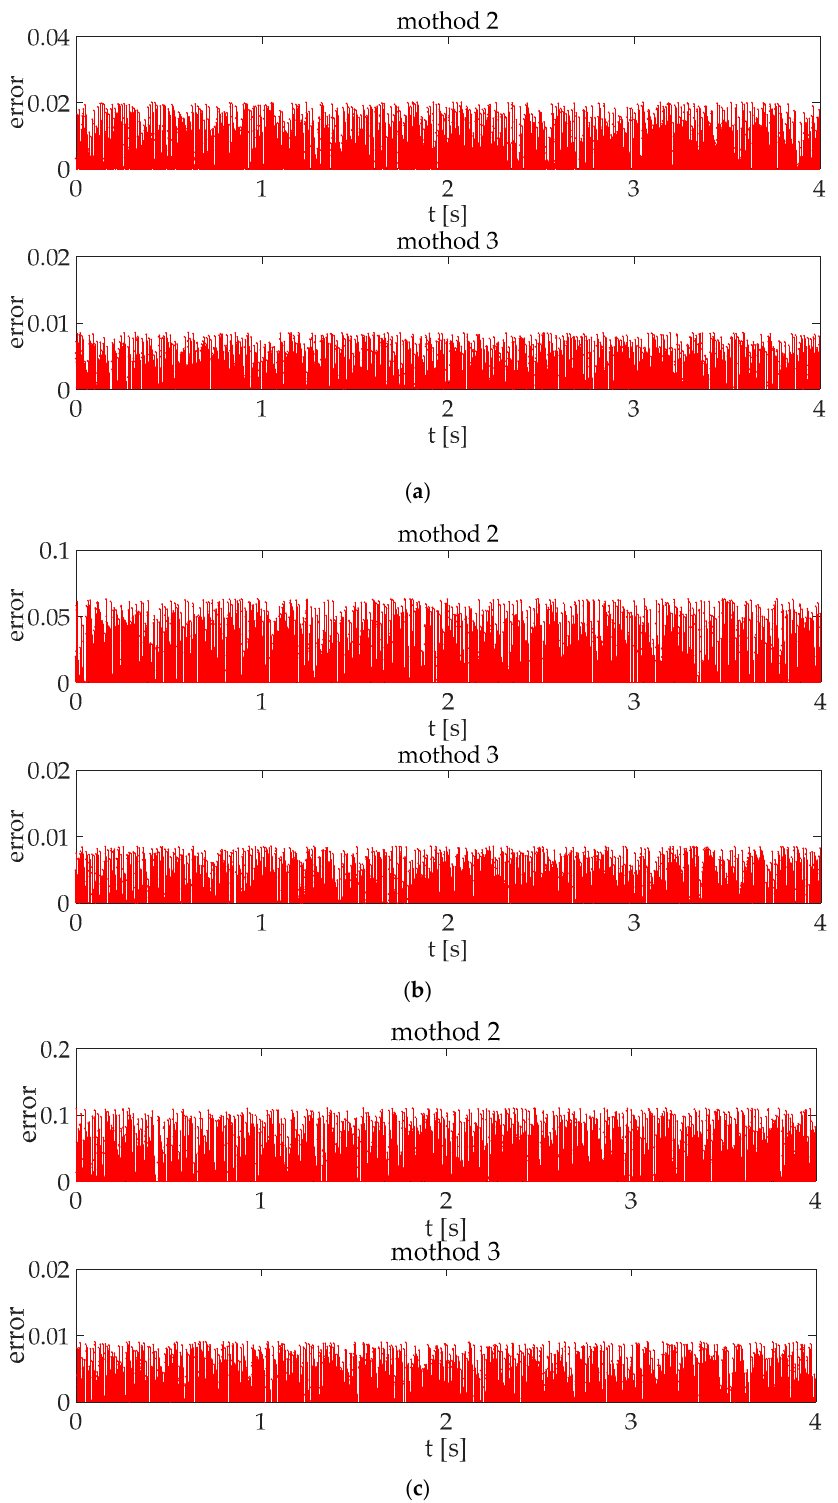
Figure 10. The error of two multi-rate methods. ( a ) When the inductance L is 0.5H, the error of two multi-rate methods. ( b ) When the inductance L is 0.1H, the error of two multi-rate methods. ( c ) When the inductance L is 0.02H, the error of two multi-rate methods.